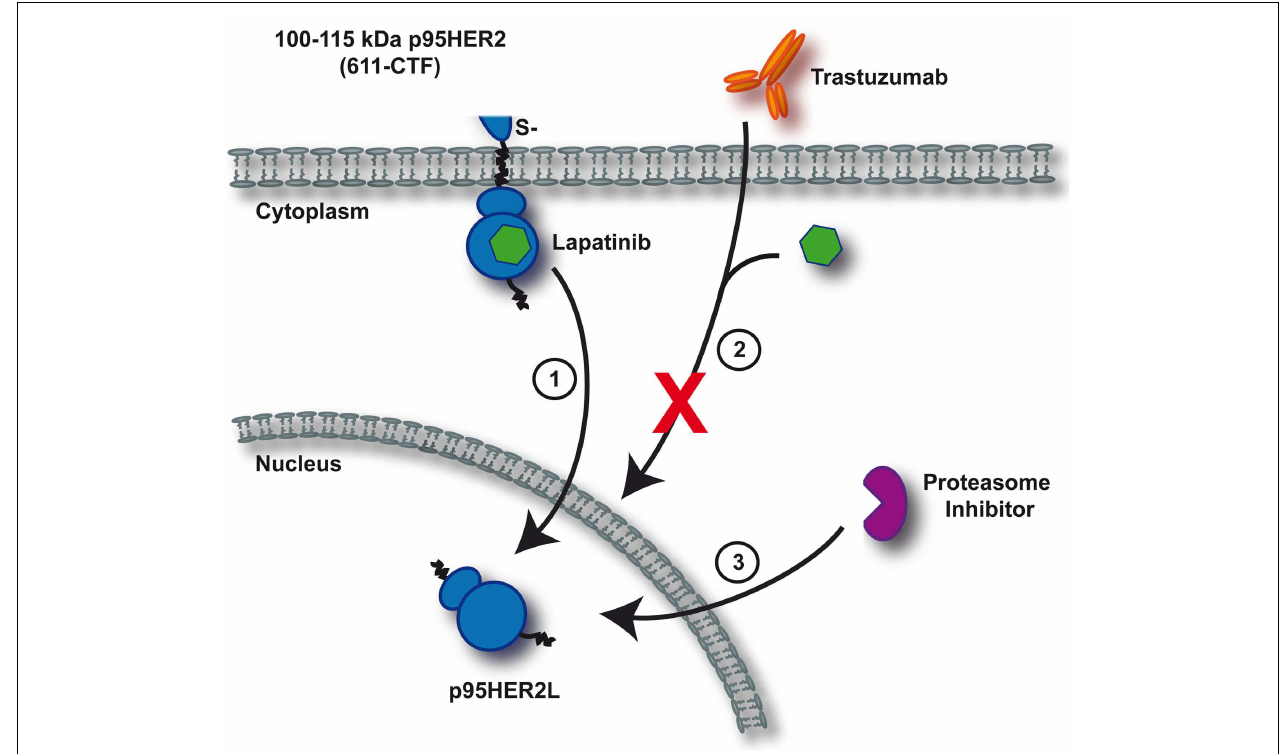
expression (1).Trastuzumab and lapatinib are ineffective in targeting nuclear p95HER2L, thereby failing to control oncogenic proliferation (2). As formation of p95HER2L potentially depends on proteasomal processing, proteasome inhibition effectively prevents p95HER2L emergence